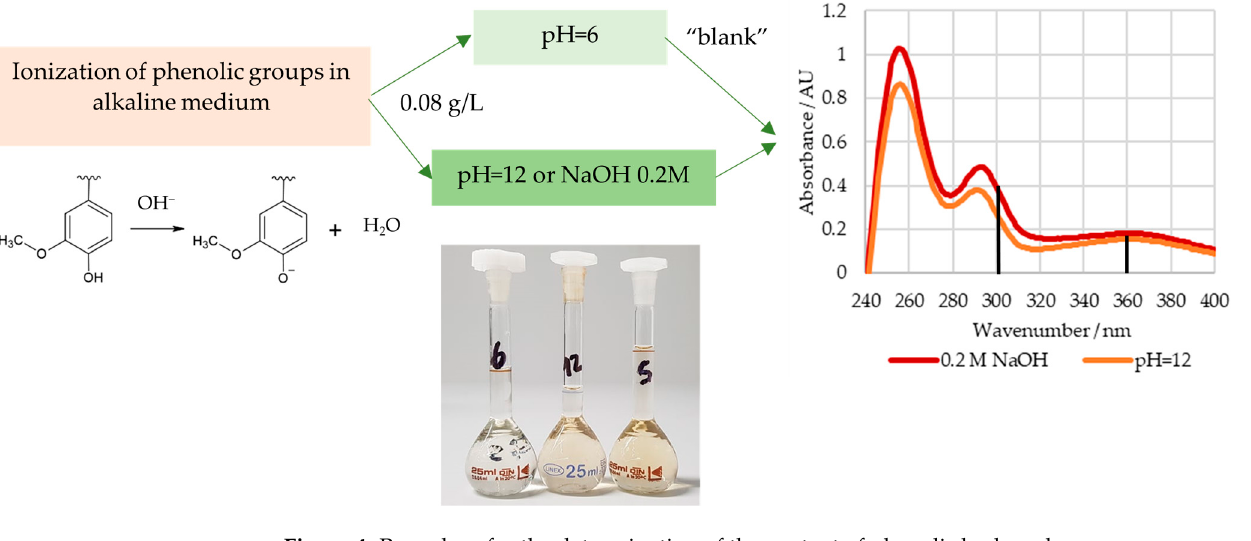
Figure 4. Procedure for the determination of the content of phenolic hydroxyl groups.